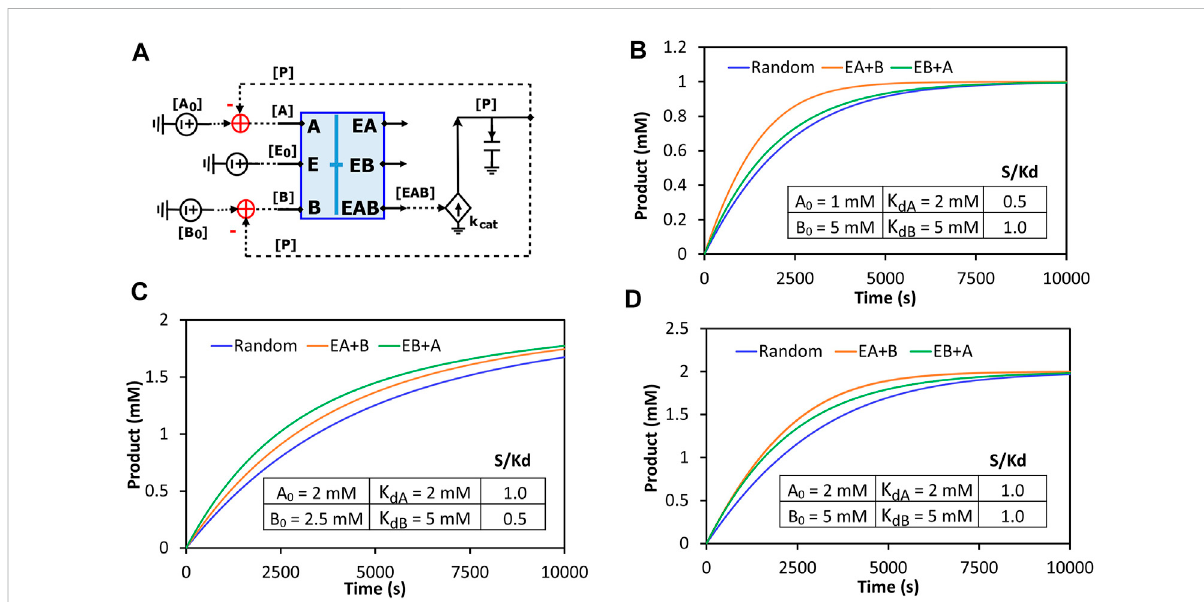
FIGURE 9 Comparison of the reaction kinetics of two-substrate reactions with random binding and ordered-binding. (A) The concise circuit schematic for the generalized reaction circuit from Supplementary Figure S2D, with a binding block (blue box) and a catalytic reaction. The binding block circuit motif (blue box) is the same circuit used in Figure 7D for ESI binding but with substrates A and B replacing S and I. Depending on parameter settings, this circuit can also simulate ordered-binding reactions as mentioned in Supplementary Figure S2E. (B – D) Product dynamics for the random- and ordered-binding reactions with different substrate-to-Kd (S/K d ) ratios. Random: random- binding reaction; EA + B: enzyme binds to A then B; EB + A: enzyme binds to B then A. The parameters used in the simulations are listed in